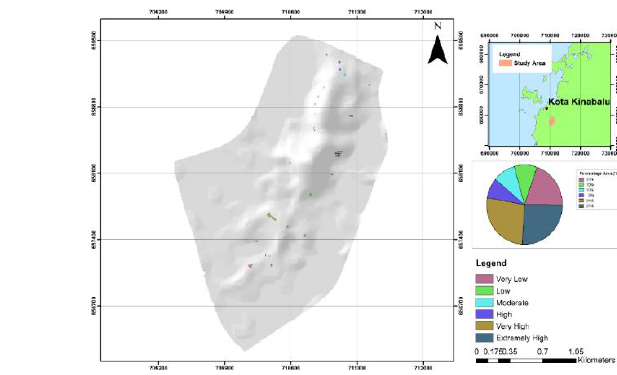
Figure 5: The geology map and stratigraphic setting of the study area